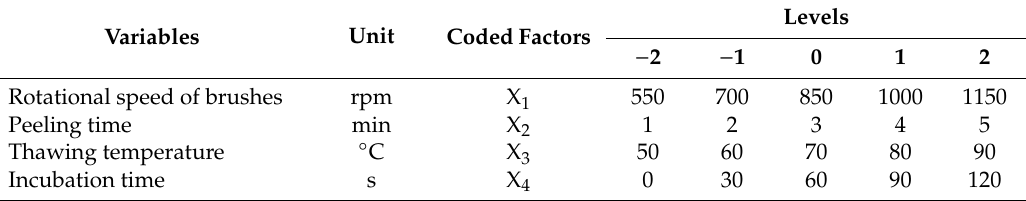
Table 1. Independent variables and limit levels for response surface